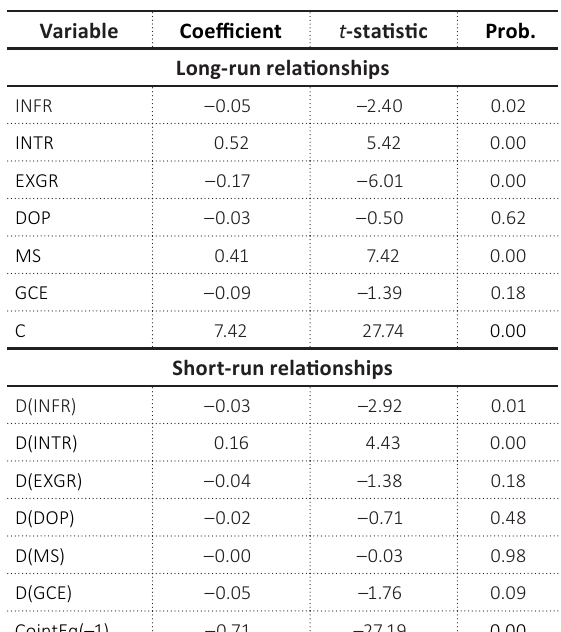
Table 6. ARDL long-run (a) and short-run relationships (b)